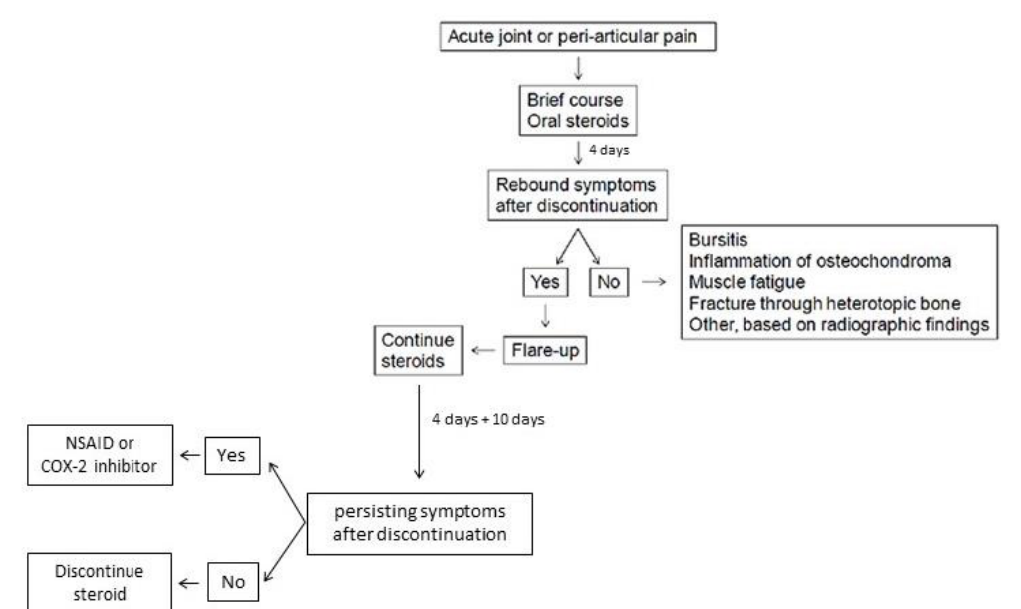
Figure 2. Algorithmic therapeutic approach for flare-ups and acute joint/periarticular pain (from [16], modified).